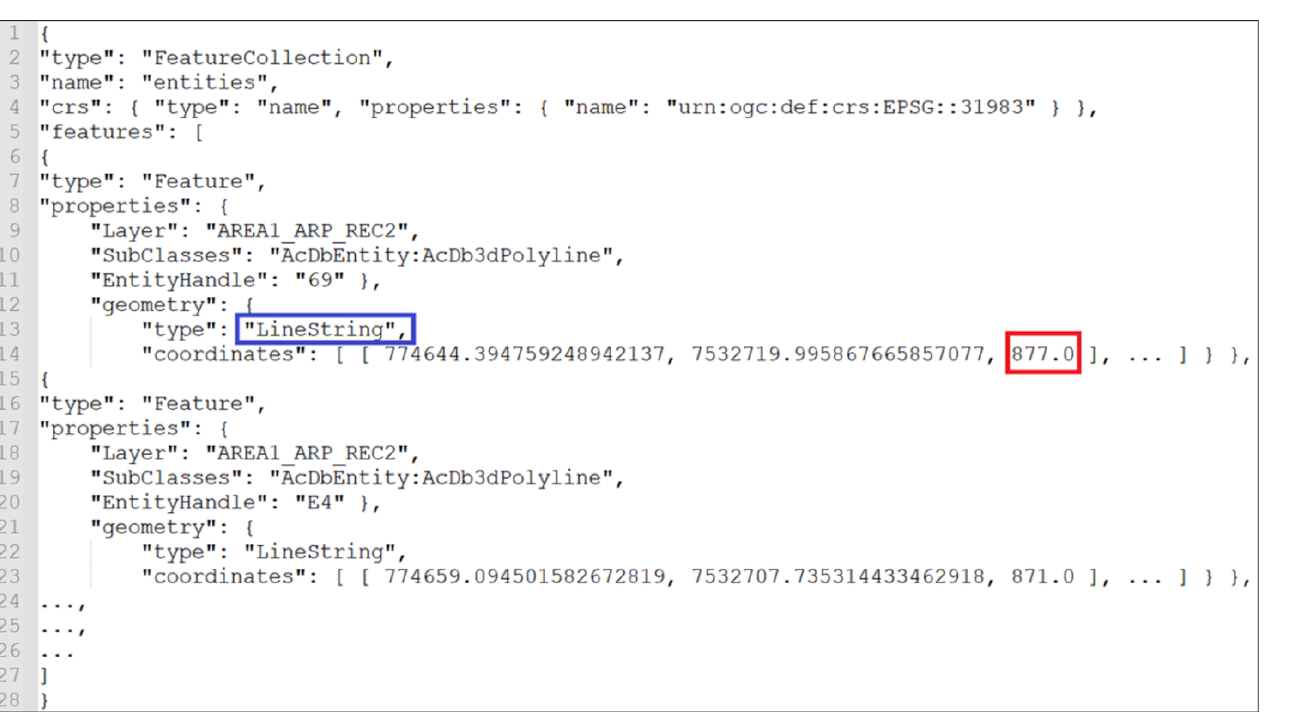
Figure 10. Implementation of the query in PHP and SQL to obtain the Hausdorff distance among features of different geospatial objects.